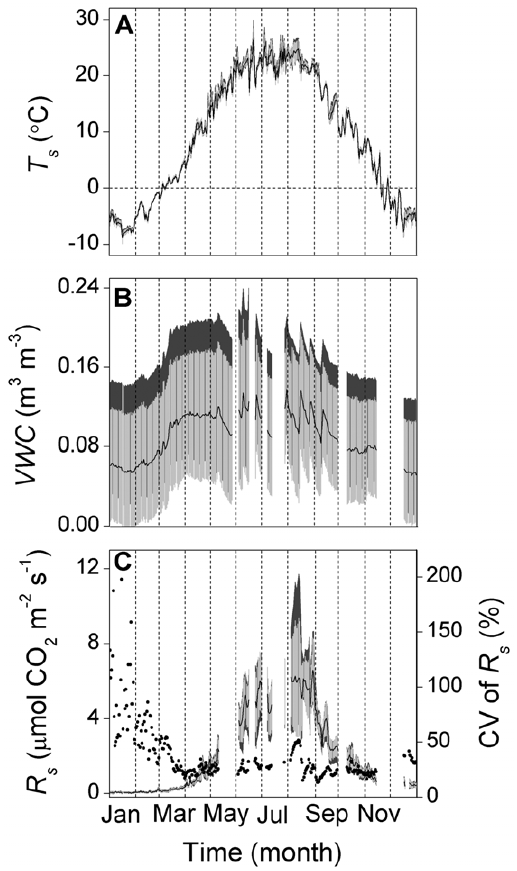
Figure 1. Soil temperature ( T s ) (A), volumetric water content ( VWC ) (B) and soil respiration ( R s ) (C). T s and VWC were monitored at 10-cm depth. Solid lines: mean across measurement locations; light grey: standard deviation among measurement locations; dark grey: range among measurement locations; black dots in (C): coefficient of variation (CV) for R s